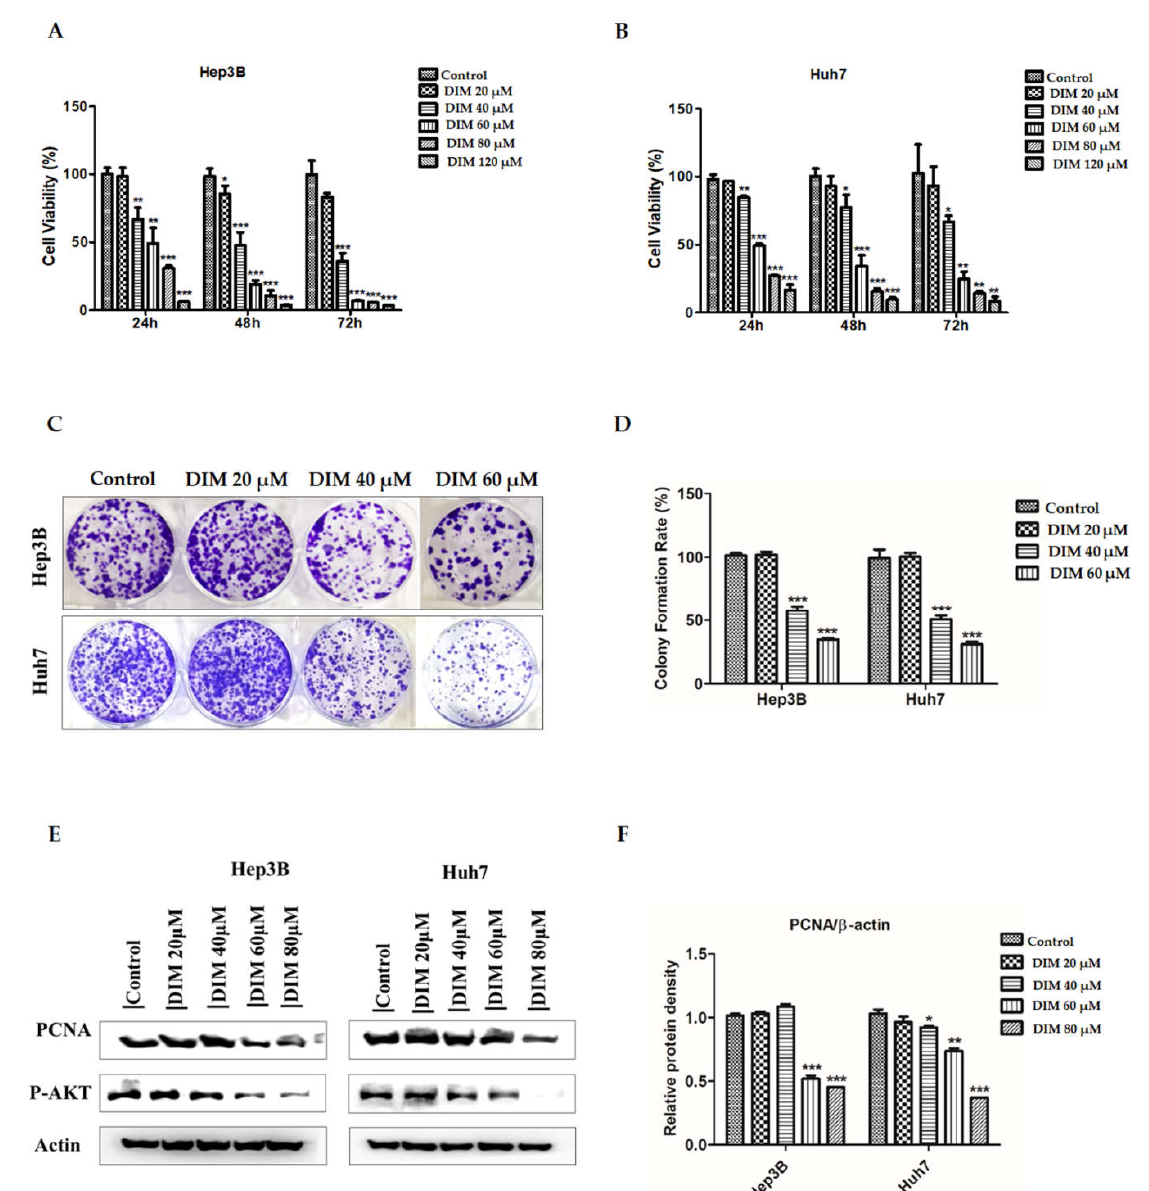
Figure 2. Inhibitory effects of DIM on cell proliferation and related proteins in Hep3B and Huh7 cells. ( A,B ) MTT assay reveals that DIM inhibits cell proliferation of Hep3B and Huh7 HCC cell lines in a dose and time-dependent manner. The bar graph represents the percent proliferation rate compared with the non-treated control. ( C ) Inhibitory effects of DIM on colony formation ability of Hep3B and Huh7 cells. ( D ) Bar graphs indicate quantitative analysis of the number of colonies formed in DIM-treated cells compared to that in the control group of Hep3B and Huh7 cells. ( E ) Western blotting analysis of proliferation-related proteins PCNA and p-AKT in Hep3B and Huh7 cells treated with indicated concentration of DIM for 24 h. ( F ) Bar graphs represent quantification of relative protein expression normalized to β-actin. All data are from three separate experiments ( n = 3) and expressed as mean ± SE. *, p < 0.05; **, p < 0.01; and ***, p < 0.001, significant difference compared to the control group.